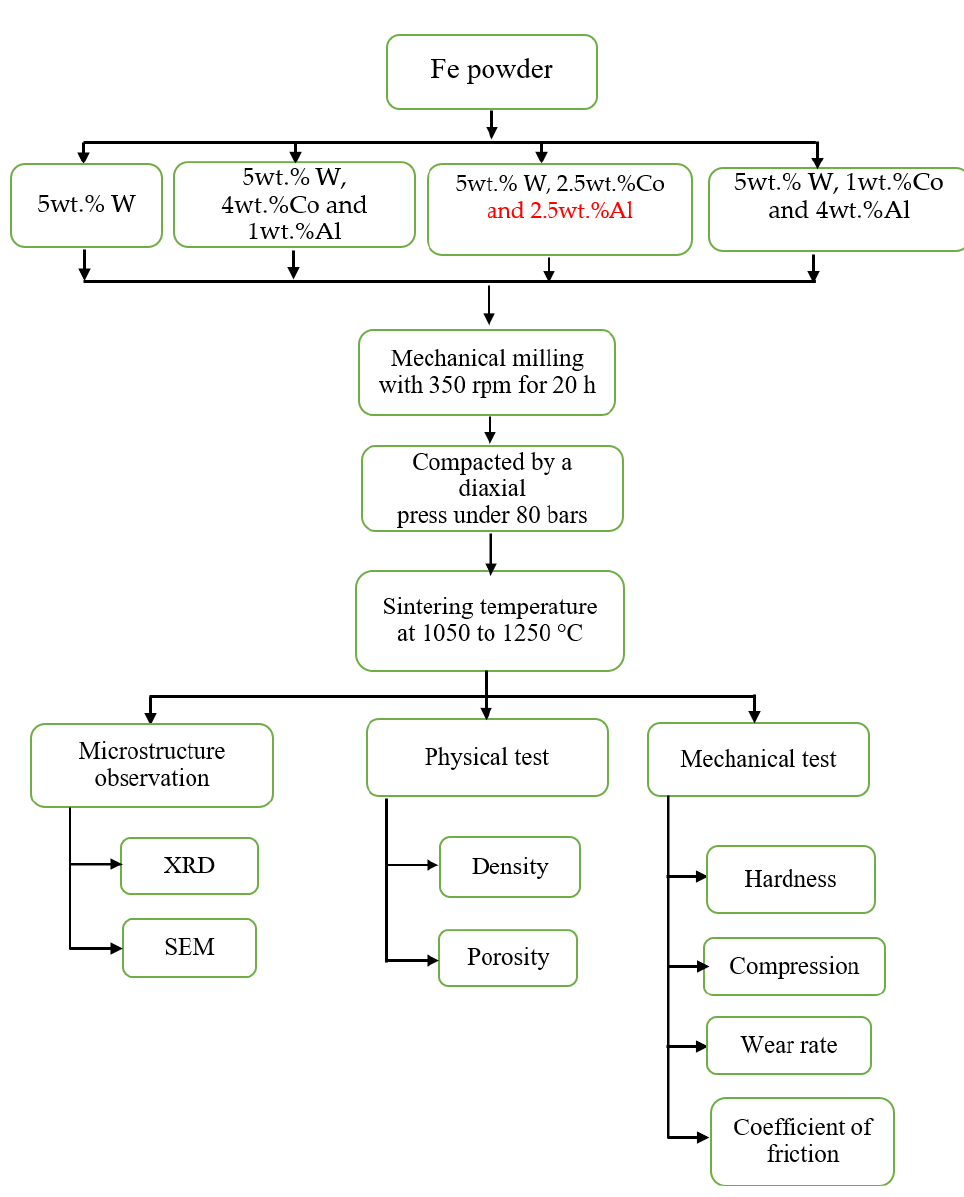
Figure 1. Flow chart of the experimental procedures.